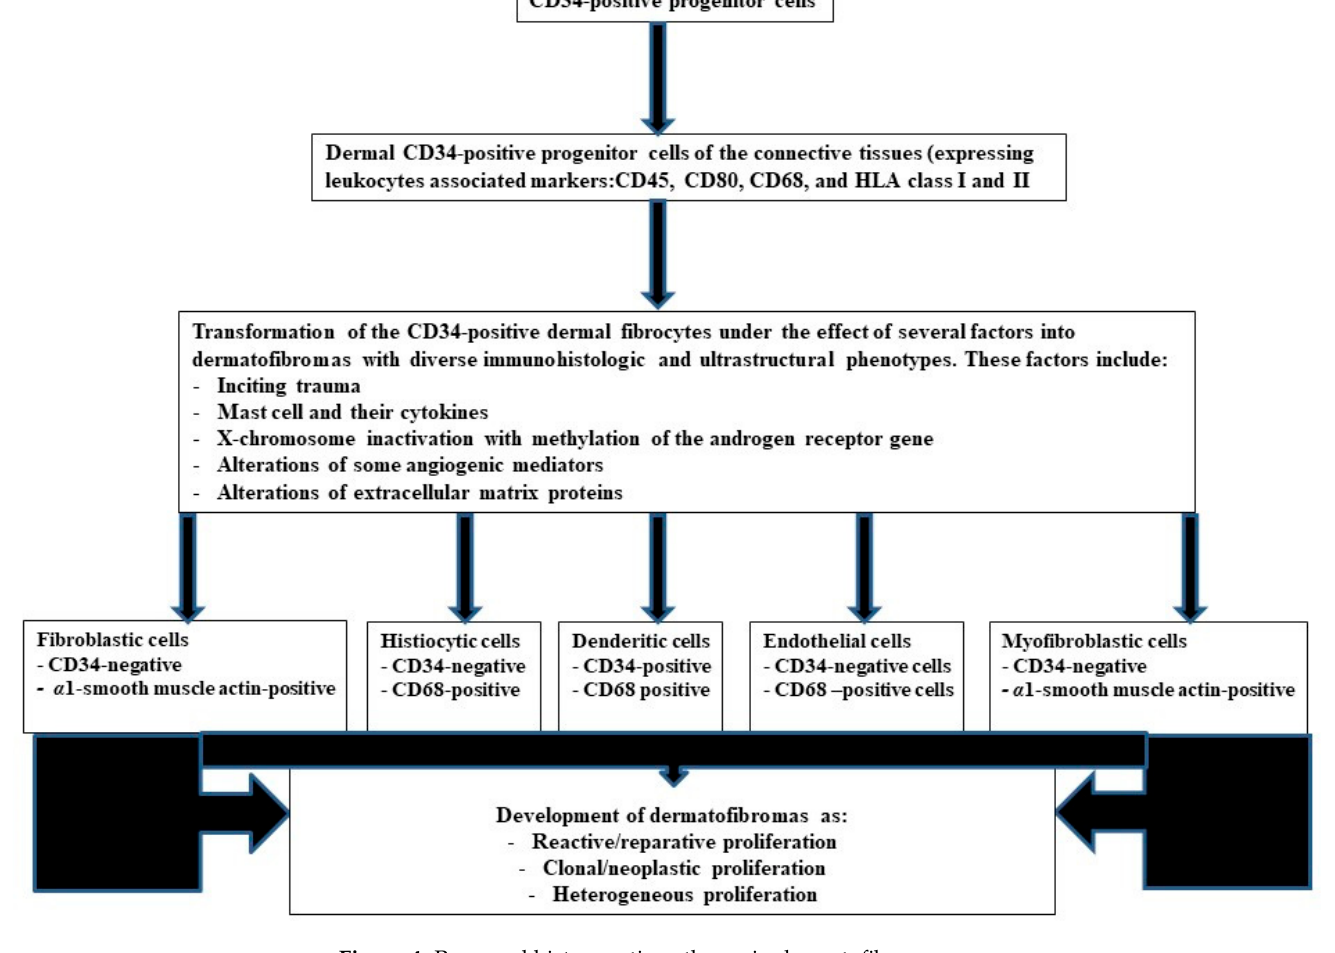
Figure 4. Proposed histogenetic pathway in dermatofibromas.